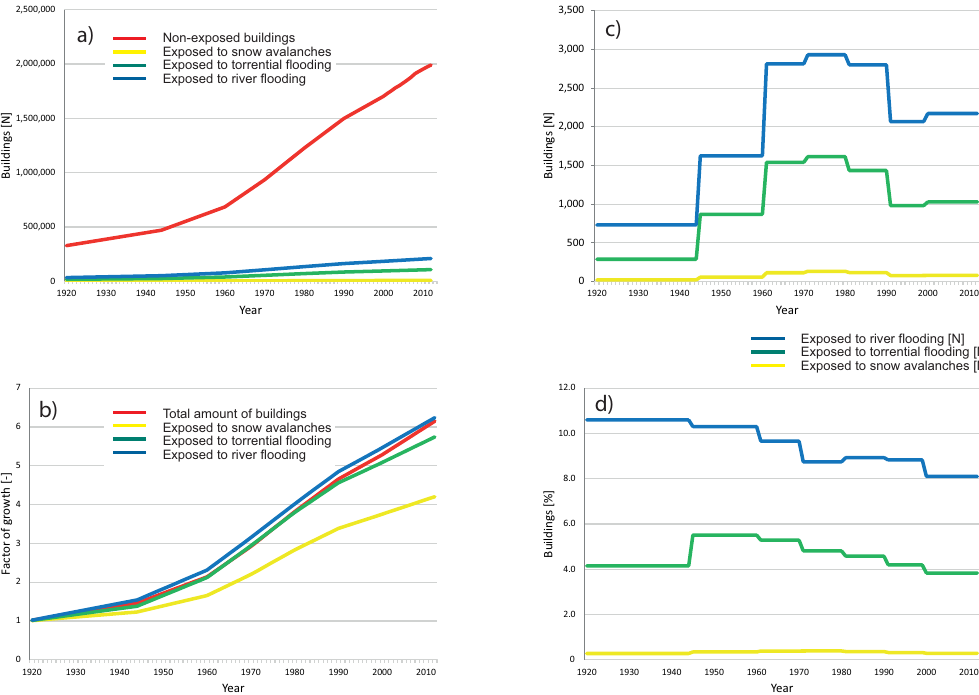
Figure 4. Temporal development of building stock in Austria. In (a) the cumulative absolute increase in the number of buildings is shown for non-exposed buildings and buildings exposed to snow avalanches, torrential as well as river flooding. In (b) the relative increase of the building stock is shown for the total number of buildings and buildings exposed to snow avalanches, torrential as well as river flooding, 1919 = 1. In (c) the average annual number of newly constructed buildings is shown for buildings exposed to snow avalanches, torrential as well as river flooding. In (d) the annual number of newly constructed exposed buildings versus the total number of newly-constructed buildings is shown for buildings exposed to snow avalanches, torrential as well as river